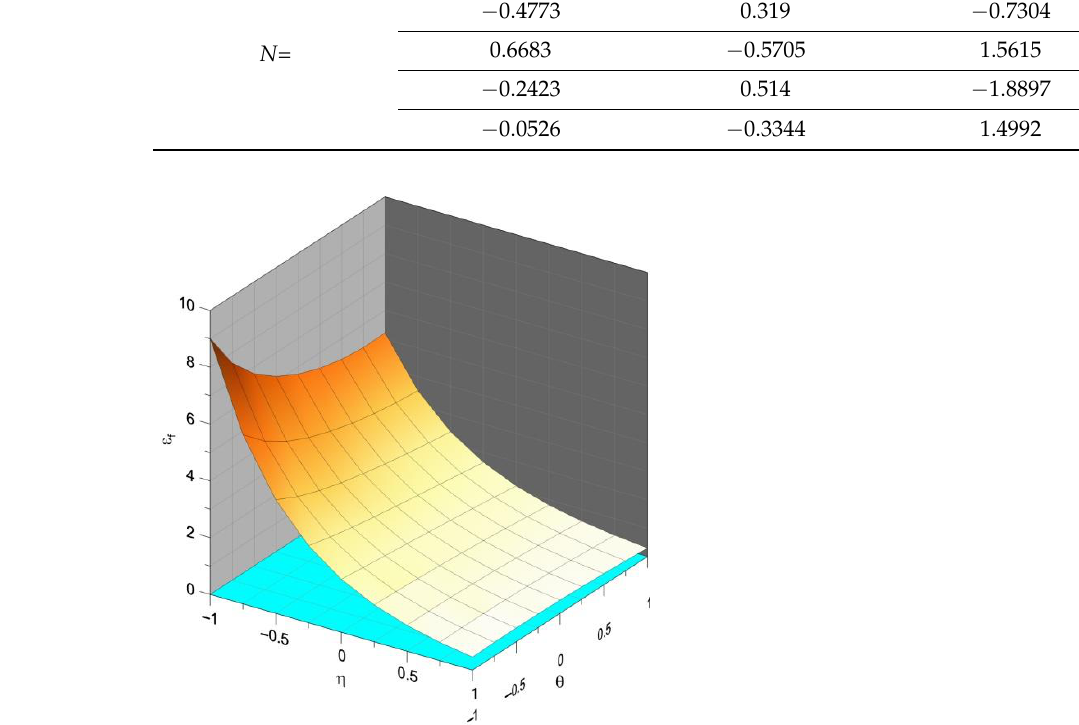
Table 1. Coefficients of the fracture locus (source: own computations). Table 3. Coefficients of the fracture locus (source: own computations).